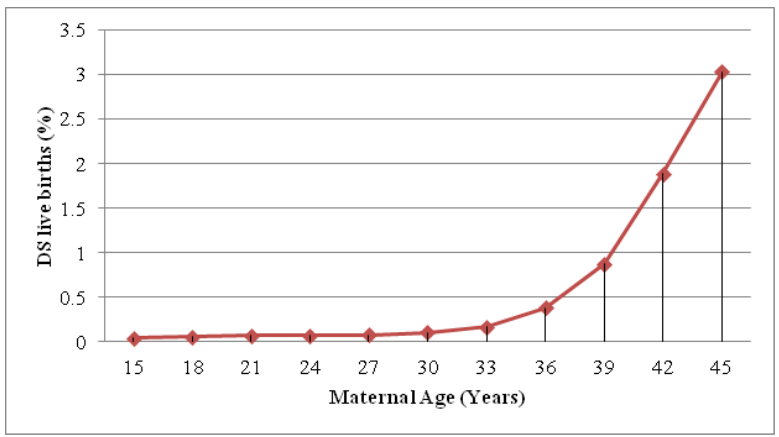
Figure 1. The estimated risk of DS according to maternal age (adapted from